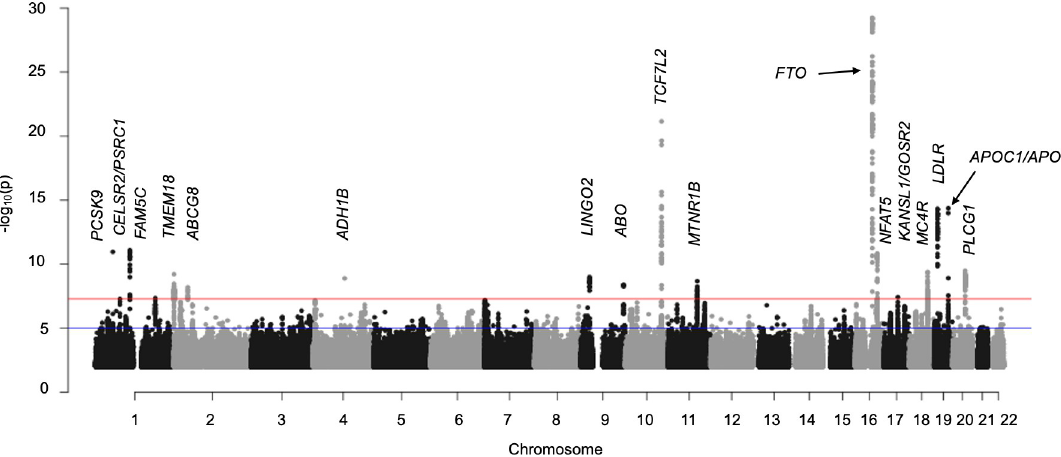
Fig 1. Multi-population ideal health score discovery GWAS Manhattan plot (N = 142,404). The negative log of the SNP p-value is plotted by chromosomal position (hg19) across the genome. Horizontal lines indicating genome-wide significant (p < 5 × 10 − 8 ) and suggestive levels (p < 1 × 10 − 5 ) are indicated by red and blue lines respectively. Transition between black and gray is used to define chromosome boundaries. Loci achieving genome-wide significance are annotated with the name of gene(s) in the region. https://doi.org/10.1371/journal.pone.0267900.g001 P � 2.94 × 10 − 3 . In the combined discovery GWAS cohort and replication cohort meta-analyses (N = 188,170), the effect direction was consistent and p-values for all SNPs remained genome- wide significant (Table 3). In a sensitivity analysis in the discovery GWAS cohort removing individuals with CVD at baseline (N = 98,741), beta coefficients and direction of effect for the 17 SNPs were similar to those from the overall discovery GWAS cohort ( S6 Table of S1 File). Table 2. Multi-population meta-analysis results for ideal health score and results for top 17 SNPs from binary ideal health genome-wide association study (N = 142,404). Gene